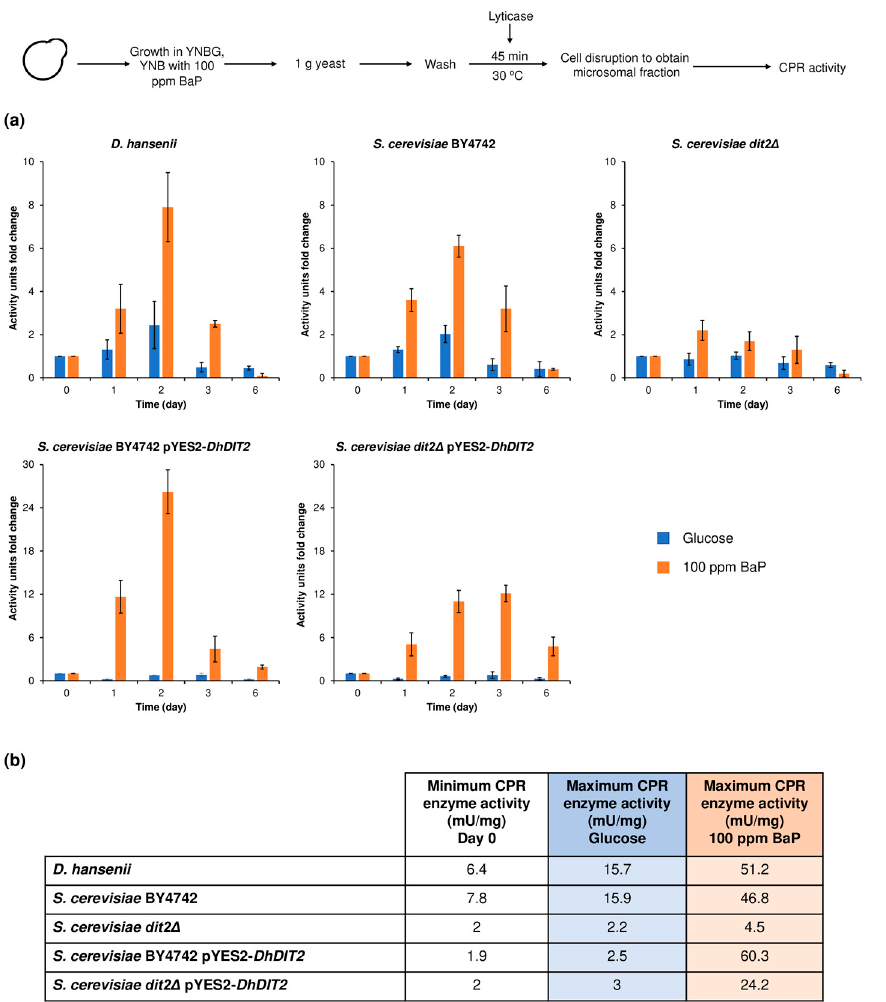
Figure 8. NADPH-cytochrome c reductase (CPR) activity during a 6-day exposure to BaP. ( a ) Increase in CPR enzyme activity (fold–change). ( b ) Maximum and minimum CPR activity. Cells were grown for 24 h in YNB medium supplemented either with 2% glucose or 2% galactose. Then, they were incubated in YNB medium containing either 0.2% glucose or 0.2% galactose supplemented with 100 ppm BaP. Each day, the microsomal fraction was extracted using 1 g (wet weight) of biomass and CPR enzyme activity was measured as indicated in the Section 2. Results represent an average value ± SD of three independent